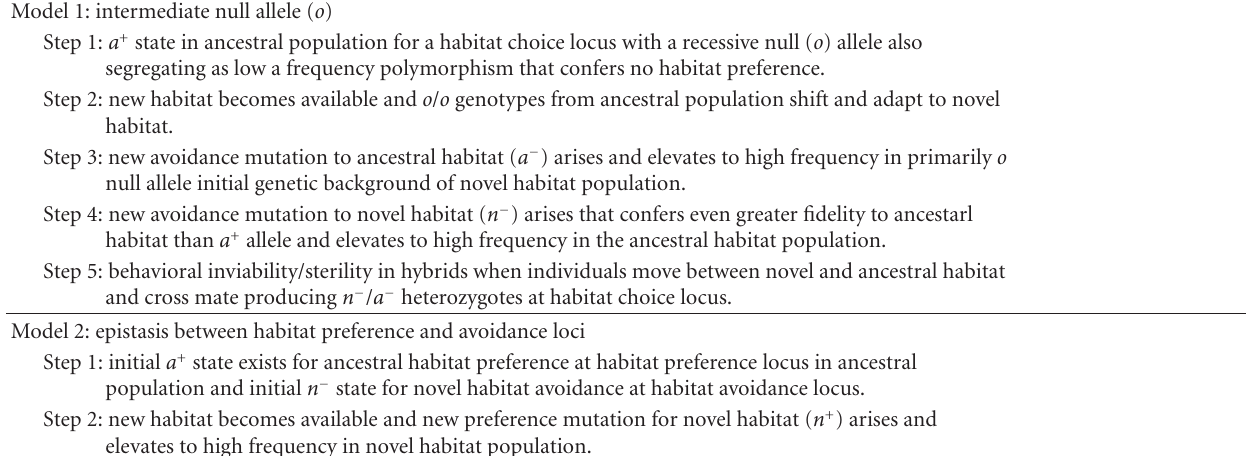
Table 1: Three models for how genetically based behavioral incompatibilities due to conflicting habitat avoidance can evolve during speciation-with-gene-flow that cause postzygotic isolation in hybrids (see Figures 1–3). Model 1: intermediate null allele ( o